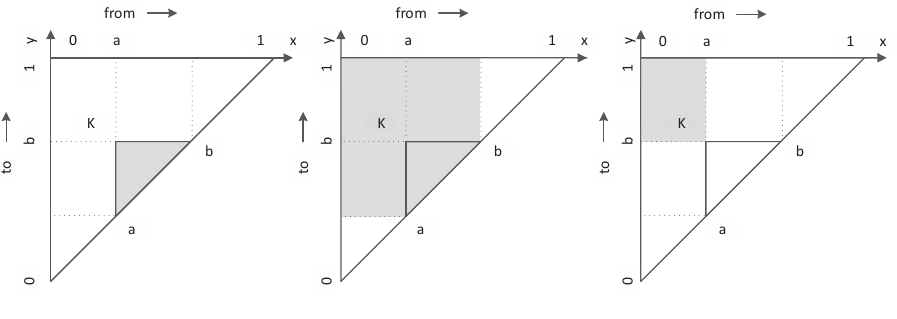
Figure 1. Graphical representations of belief, plausibility and